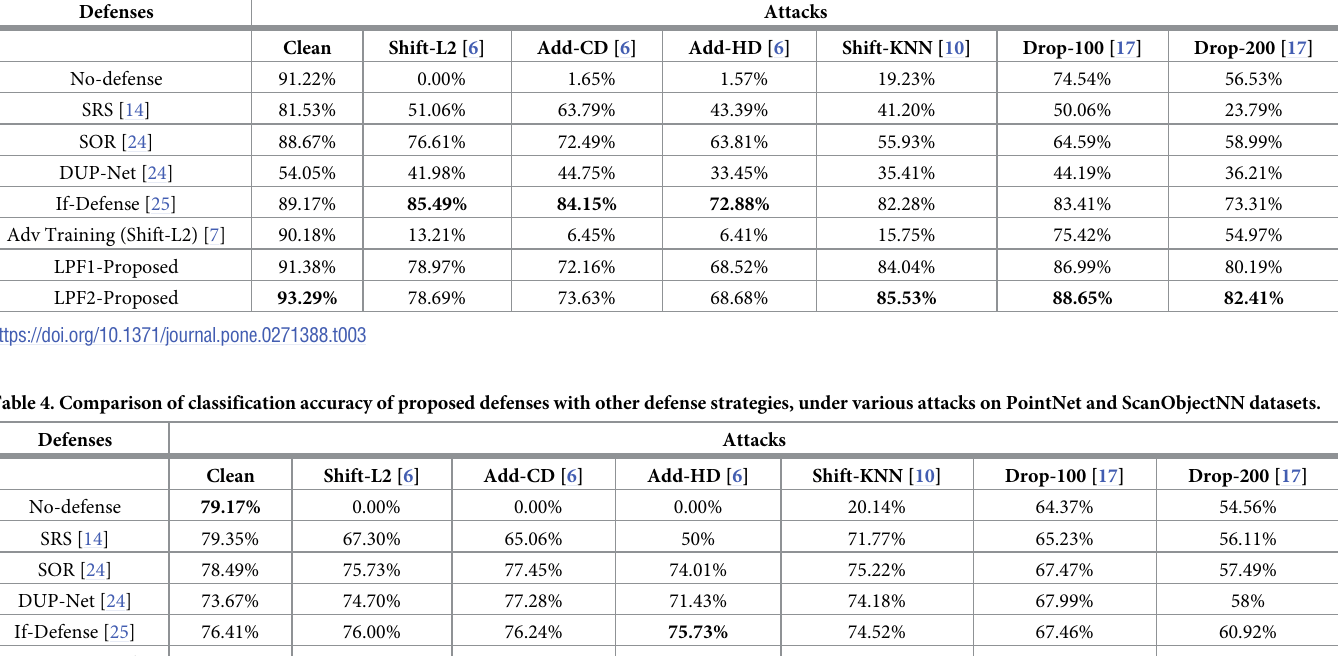
Table 3. Comparison of classification accuracy of proposed defenses with other defense strategies, under various attacks on DGCNN and ModelNet40 datasets. Defenses